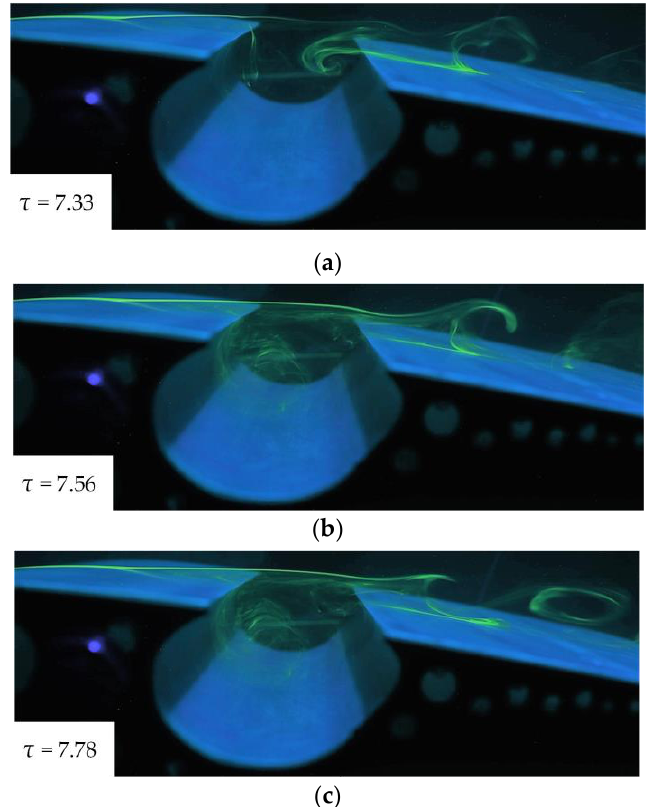
Figure 19. Flow images for cavity B at Re = 2 × 10 4 , α = 6°: ( a ) τ = 7.33; ( b ) τ = 7.56; ( c ) τ = 7.78.